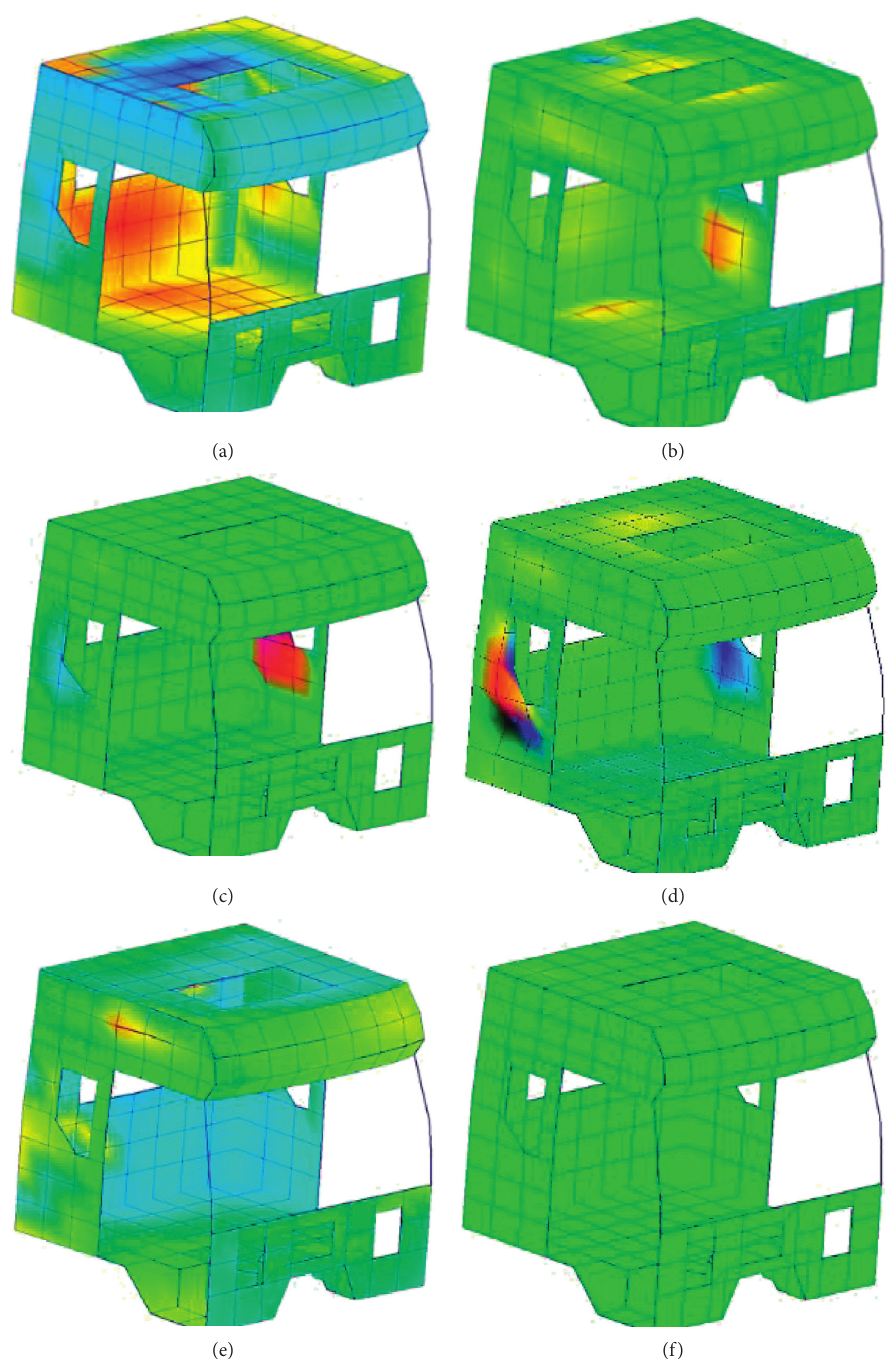
Figure 9: Experimental modal test results of cab skeleton. (a) 1th mode (21.23Hz). (b) 2nd mode (24.73 Hz). (c) 3rd mode (28.14 Hz). (d) 4th mode (30.45 Hz). (e) 5th mode (32.11 Hz). (f) 6th mode (32.76